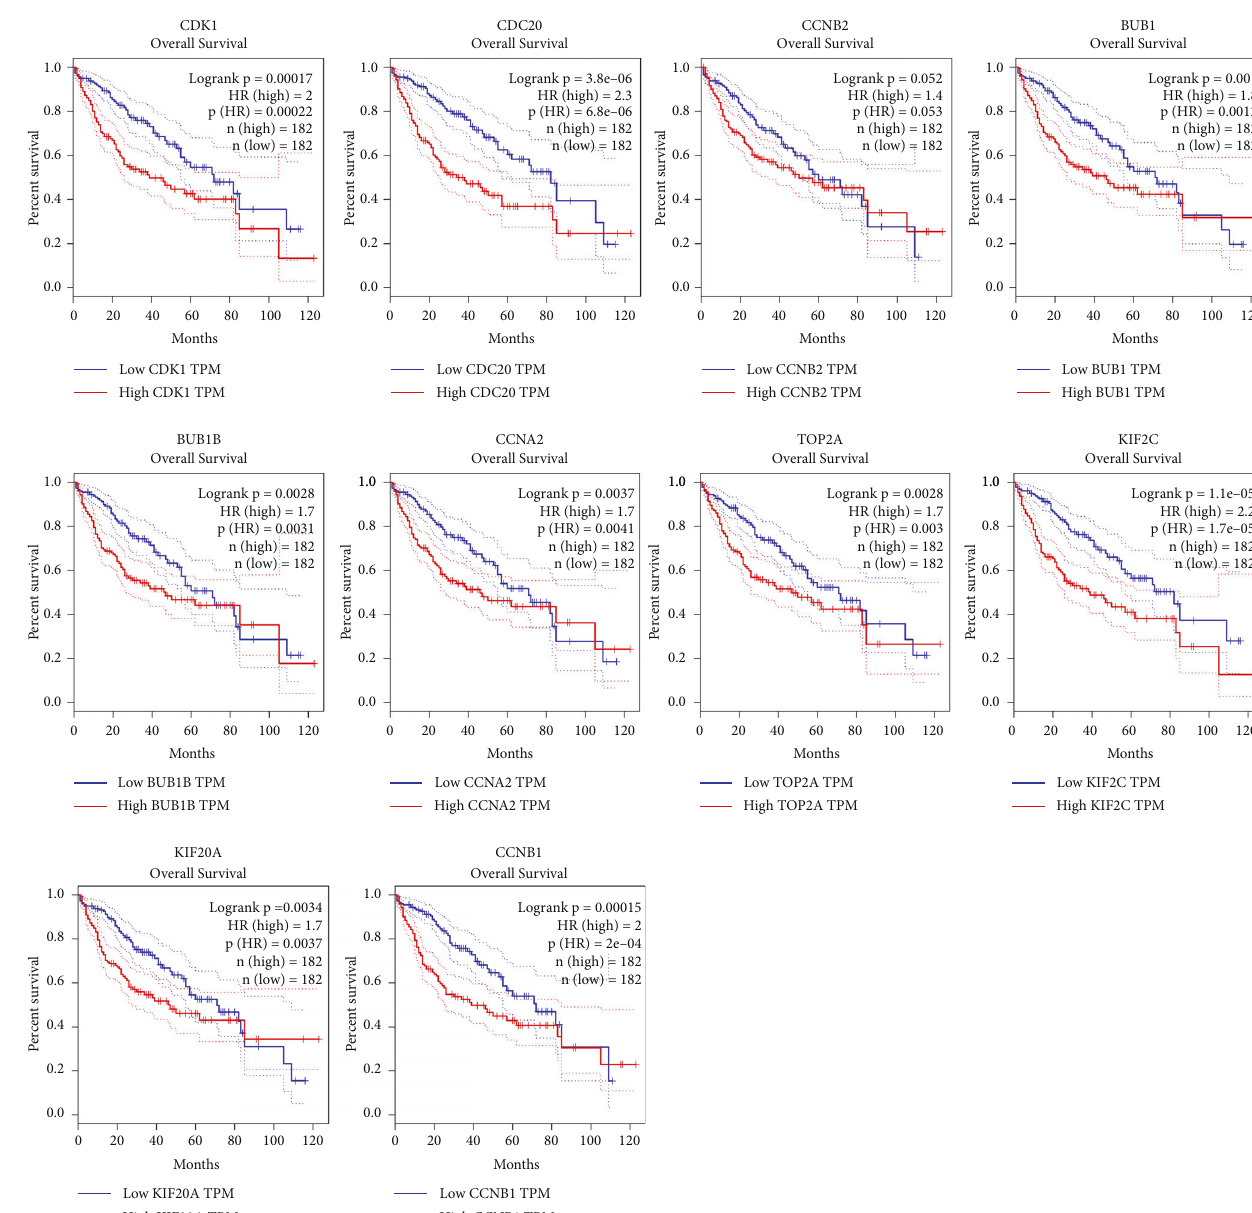
Figure 6: The link between CDK1, CDC20, CCNB2, BUB1, BUB1B, CCNA2, TOP2A, KIF2C, KIF20A, and CCNB1 expression and OS of HCC patients was determined by presented as volcano plots (Figures 1(g), 1(h), and 1(i)). In GSE33294, 1790 DEGs (806 up-regulated; 984 down-regulated) were detected; in GSE104310, 863 DEGs (550 up-regulated; 313 down-regulated) were detected; and in GSE144269, 767 DEGs (654 up-regulated; 113 down-regulated) were detected. Common DEGs amongcollecteddatasetswere displayedin Venndiagrams. One hundred ninety up-regulated and 51 down-regulated DEGs among the datasets were shown (Figures 2(a) and 2(b)). GSE104310, and GSE144269. In GO enrichment analysis